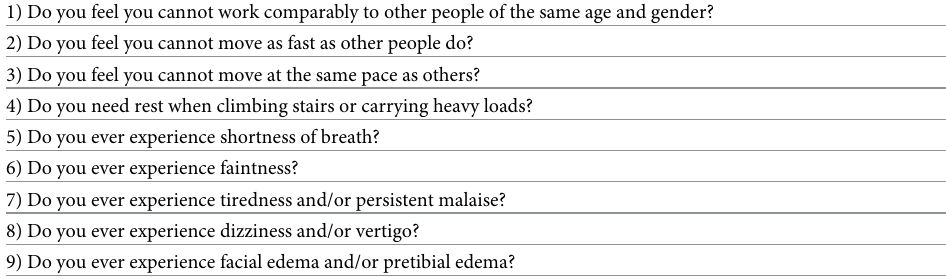
Table 2. Standardized questionnaire on symptoms suggesting portopulmonary hypertension (translated from Japanese; respondents indicate “yes” or “no”). 1) Do you feel you cannot work comparably to other people of the same age and gender?